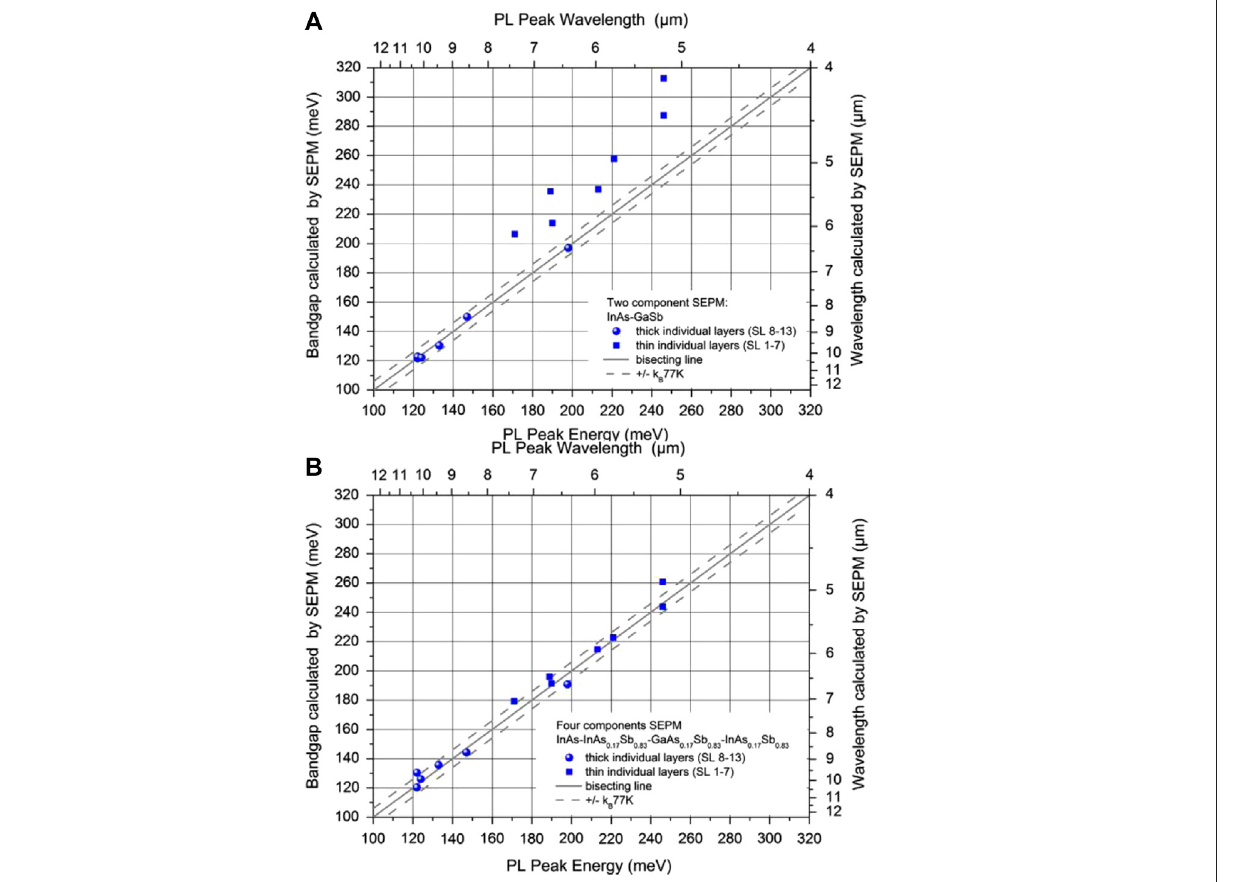
FIGURE 7 | Bandgaps calculated by the (A) two-component (InAs – GaSb) and (B) four-component (InAs – InAs 0.17 Sb 0.83 – GaAs 0.17 Sb 0.83 – InAs 0.17 Sb 0.83 ) SEPMs and their experimental values obtained from the results of PL measurements conducted at 10 ° K for T2SLs with variable layer thicknesses. The circles and squares represent thick individual layers (SL samples S 7 MLs) and thin individual layers (SL samples & 7 MLs), respectively. The dashed line represent that the measured and calculated energies match the ideal behavior to within an accuracy of ± k B at 77 K. The black symbols represents